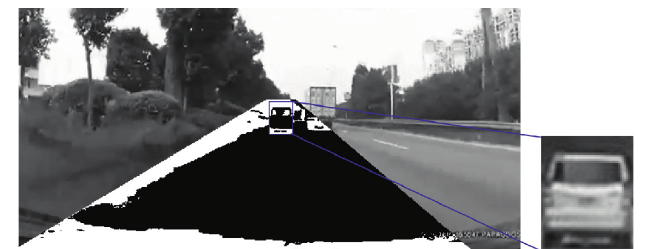
Figure 6: Vehicle assumption region.